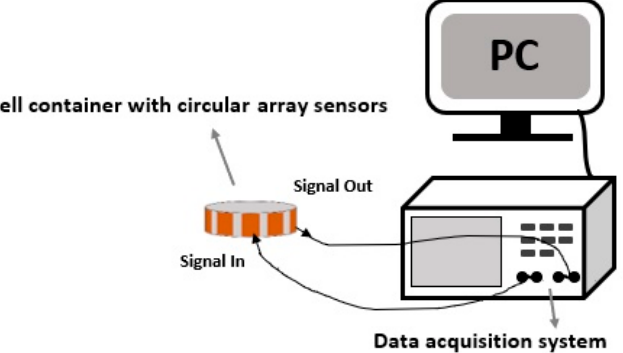
Figure 3. Construction diagram of an eight-electrode miniature CCERT system with a circular array sensor.